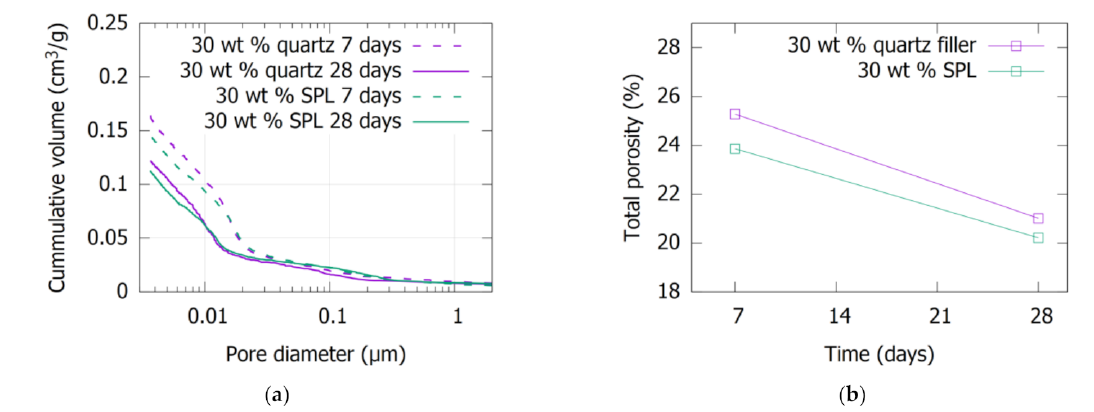
Figure 8. Pore volume distribution ( a ) and total porosity ( b ) obtained from mercury intrusion porosimetry measurements. A measurement using 30 wt% SPL 2nd cut (70 wt% CEM I) is compared to a reference composed of 70 wt% CEM I with 30 wt% fine quartz